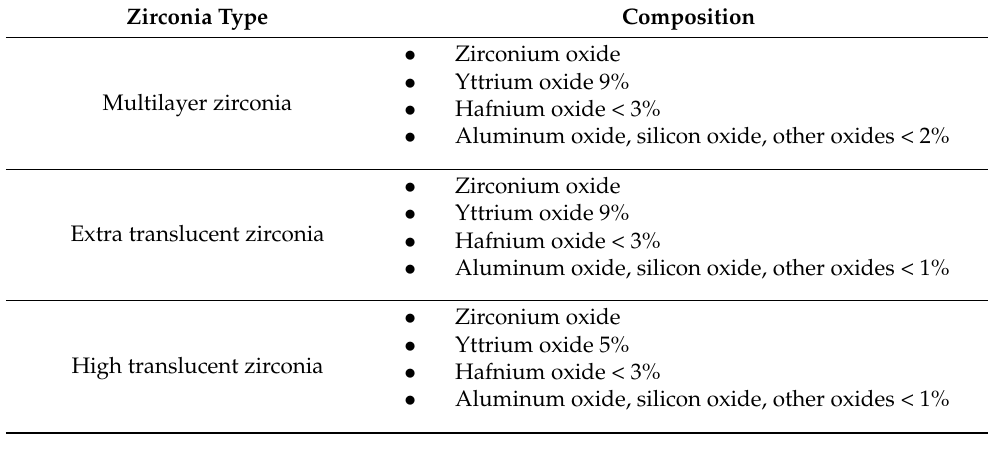
Table 1. Showing the composition of each type of zirconia used in this study.